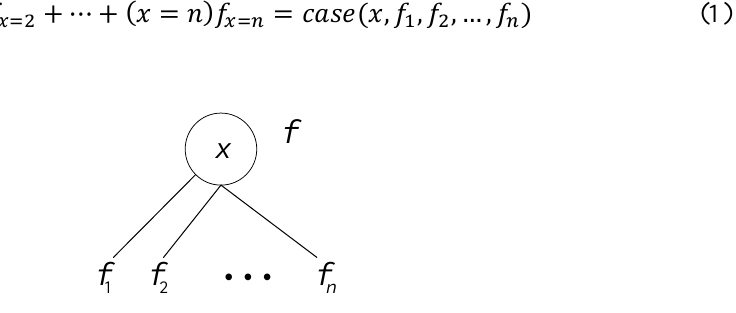
Figure 1. Illustrative general MDD structure.